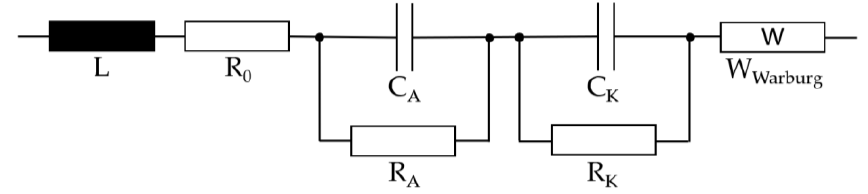
Figure 4 . Equivalent circuit of the lithium-ion cell .